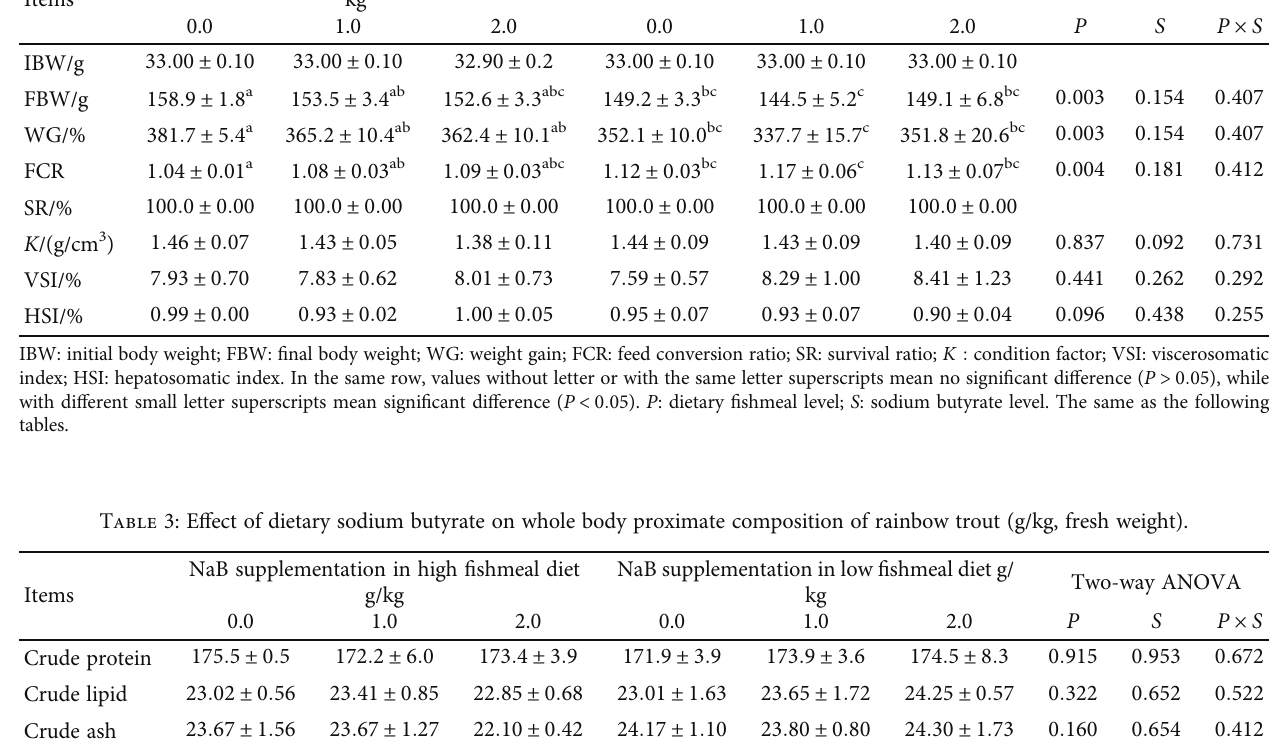
Table 2: E ff ect of dietary sodium butyrate on the growth performance of rainbow trout. NaB supplementation in high fi shmeal diet g/ NaB supplementation in low fi shmeal diet g/kg Two-way ANOVA Items kg